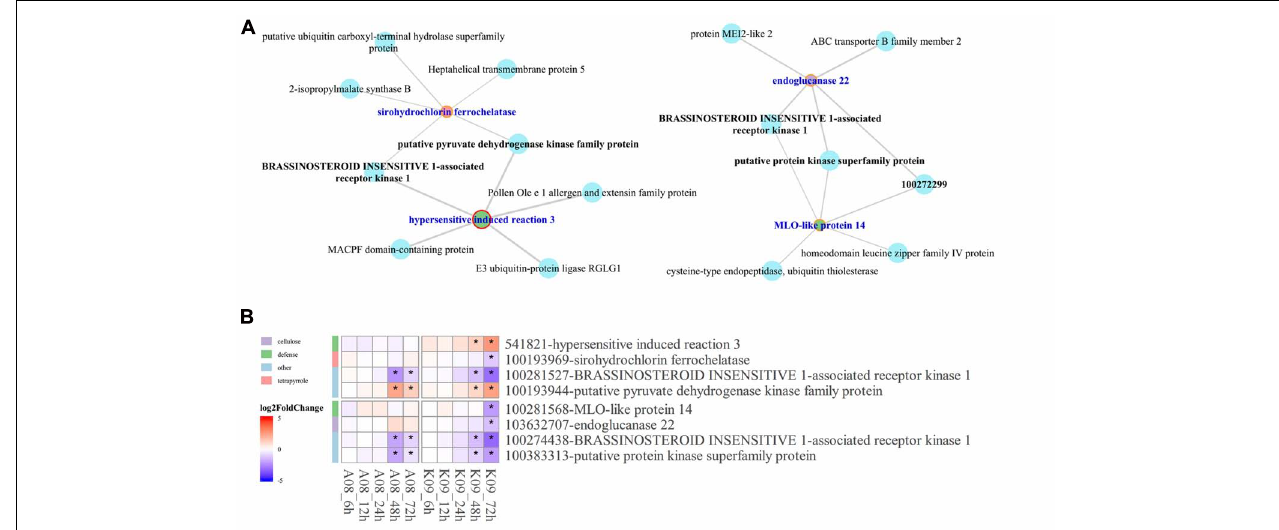
FIGURE 8 | Identification of hub genes in the co-expression networks constructed by WGCNA. (A) The subnetworks reconstructed using the pray genes and co-expressed hub genes identified from WGCNA co-expression networks using genes enriched in top 5 GO terms. Key hub genes were highlighted in blue letter and red circle. (B) Heatmaps of pray genes and hub genes identified in co-expression networks showing their co-expression pattern. The side bars with different color represent different GO terms shown on the left. The different colors in the heatmap represent log2 fold change of each gene at different time points labeled on the bottom of the map, and stars indicate the statistical significance at p <